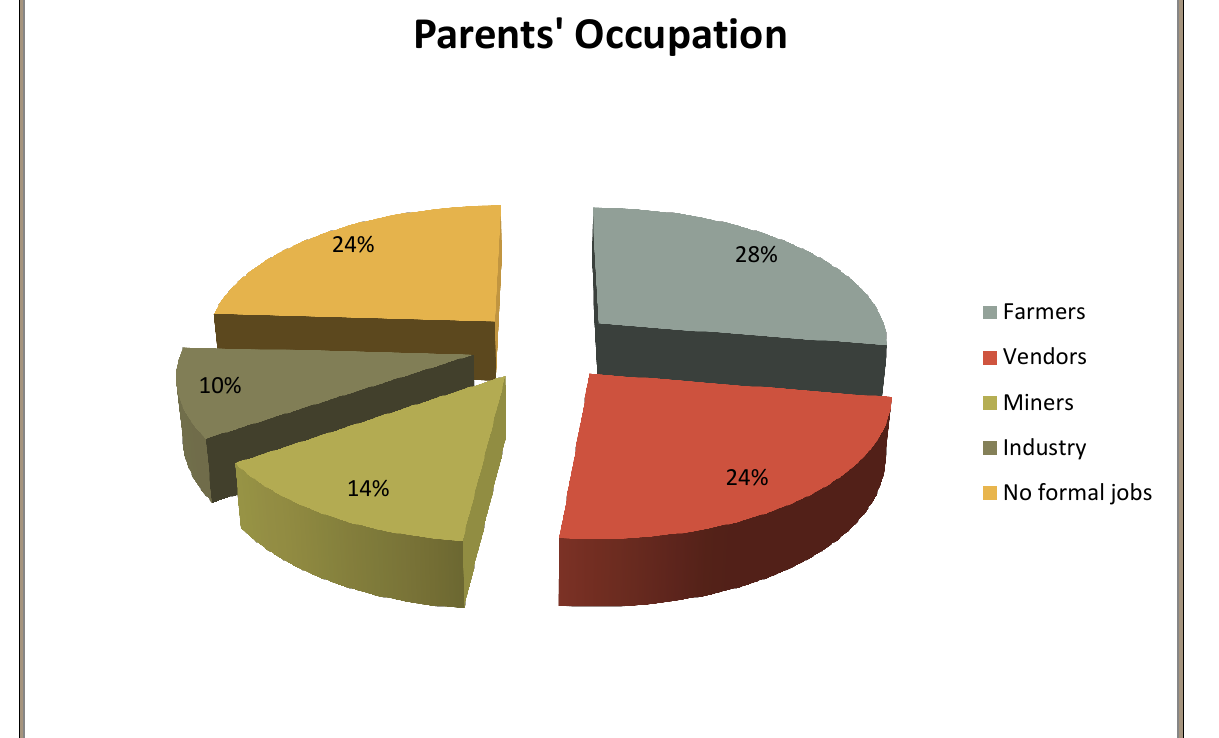
Figure 5.3: The occupations of the parents (Field data, 2013) As shown in the pie chart given, figure 5.3, fifteen (15) girl children interviewed indicated that eight (8) of their parents were farmers, seven (7) were vendors, and four (4) were miners, while three (3) worked in the industry, and seven (7) of the parents/guardians did not have formal jobs, hence the respondents described them as not working. Figure 5.3 suggests that most parents